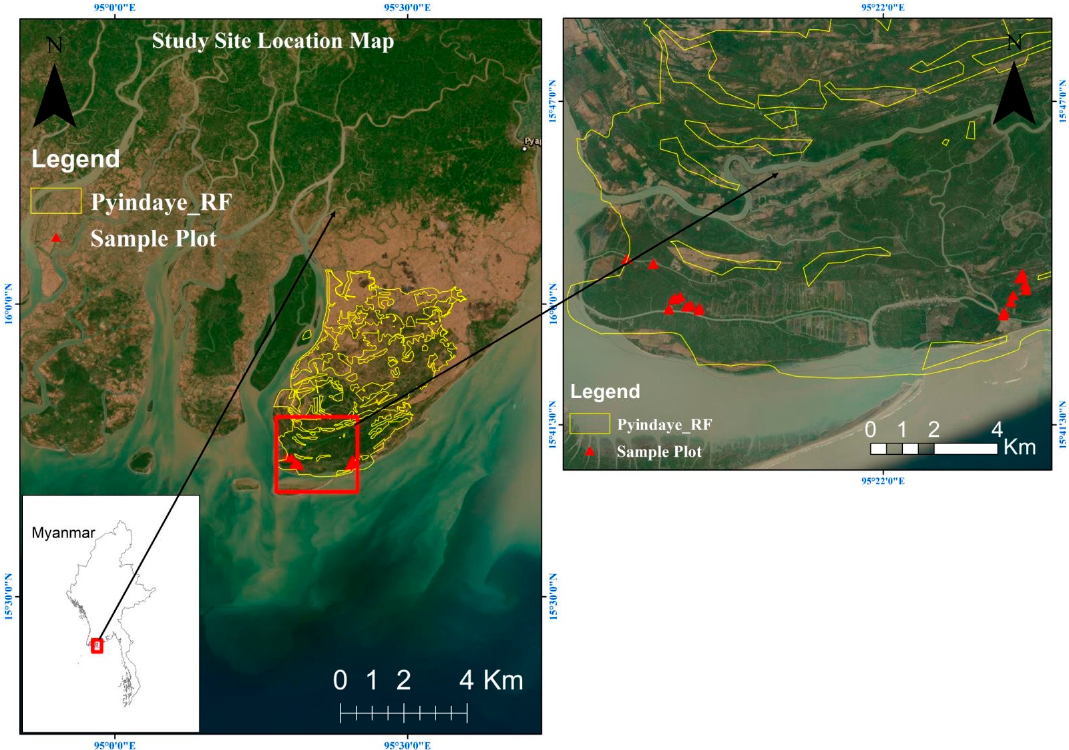
Figure 1. Map of the study sites. The basemap used was “World Imagery”, 12 March 2021 (sources: Esri, Maxar, GeoEye, Earthstar Geographics, CNES/Airbus DS, USDA, USGS, AeroGRID, IGN, and the GIS User Community, v10.8).